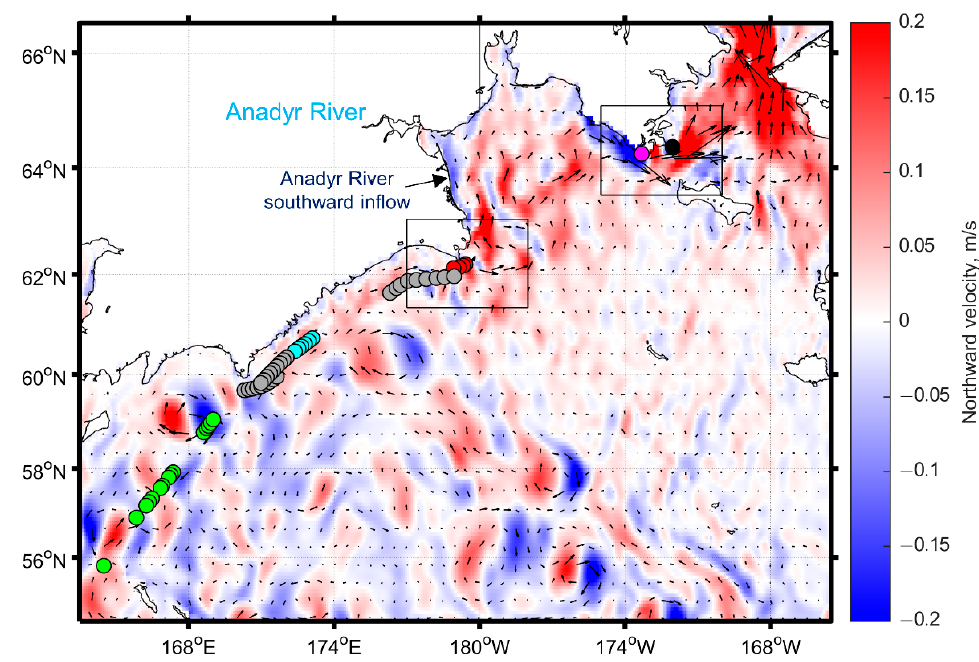
Figure 2. Northward velocity of the sea surface current averaged for the August 2013 (from the CMEMS reanalysis). A description of the colors of the dots is presented in Table 3.